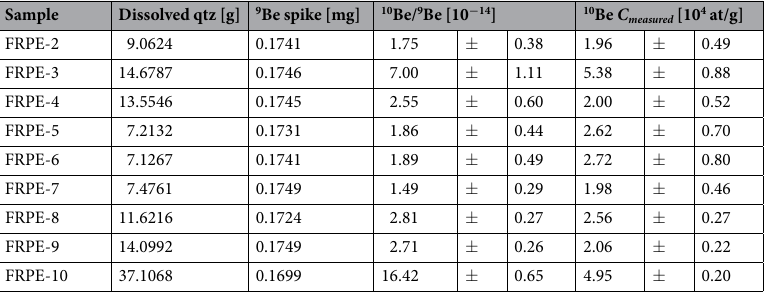
Table 2. Results of the calculations of best fit paleo-denudation rates. The estimated post-depositional concentrations are also displayed as fractions of the total measured concentrations. Bold values indicate only minimum